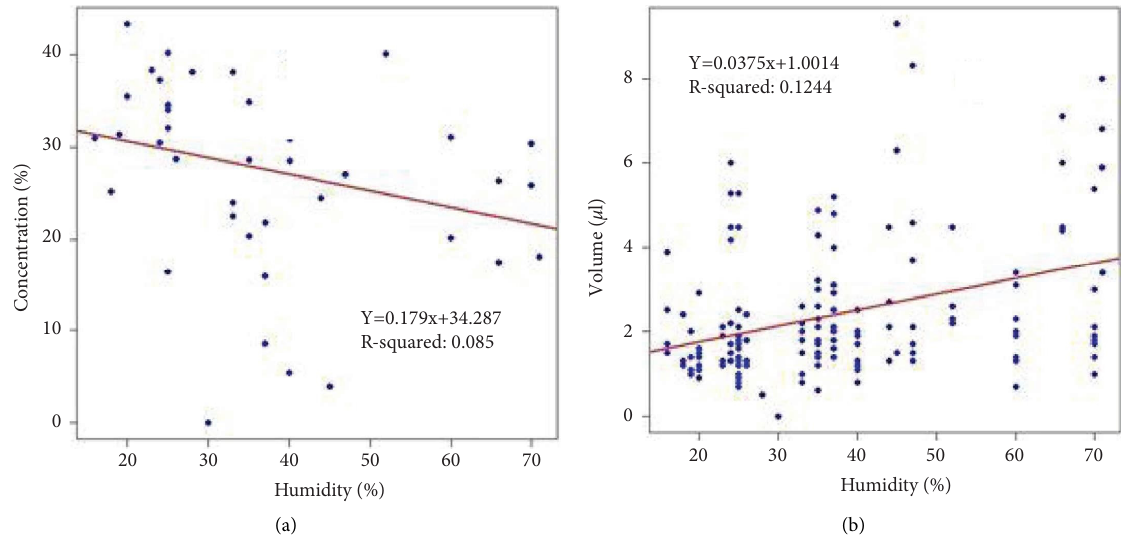
Figure 6: Efect of air humidity on nectar concentration (a) and volume (b) of Hygrophila auriculata .